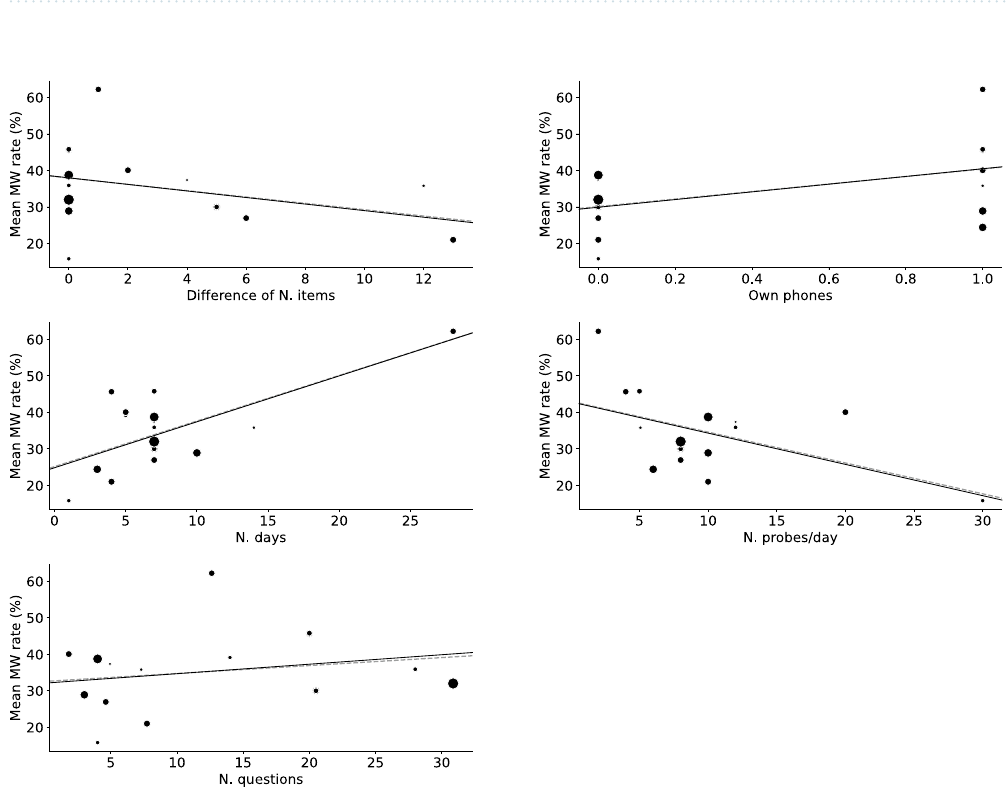
Table 2. Meta-regression results regarding MW rate. Difference of N. items Differences in the number of questions asked between scenarios when MW exists and when it does not, N. days Number of days (Experiment duration), N. probes/day Expected number of probes per day, N. questions Expected number of questions.